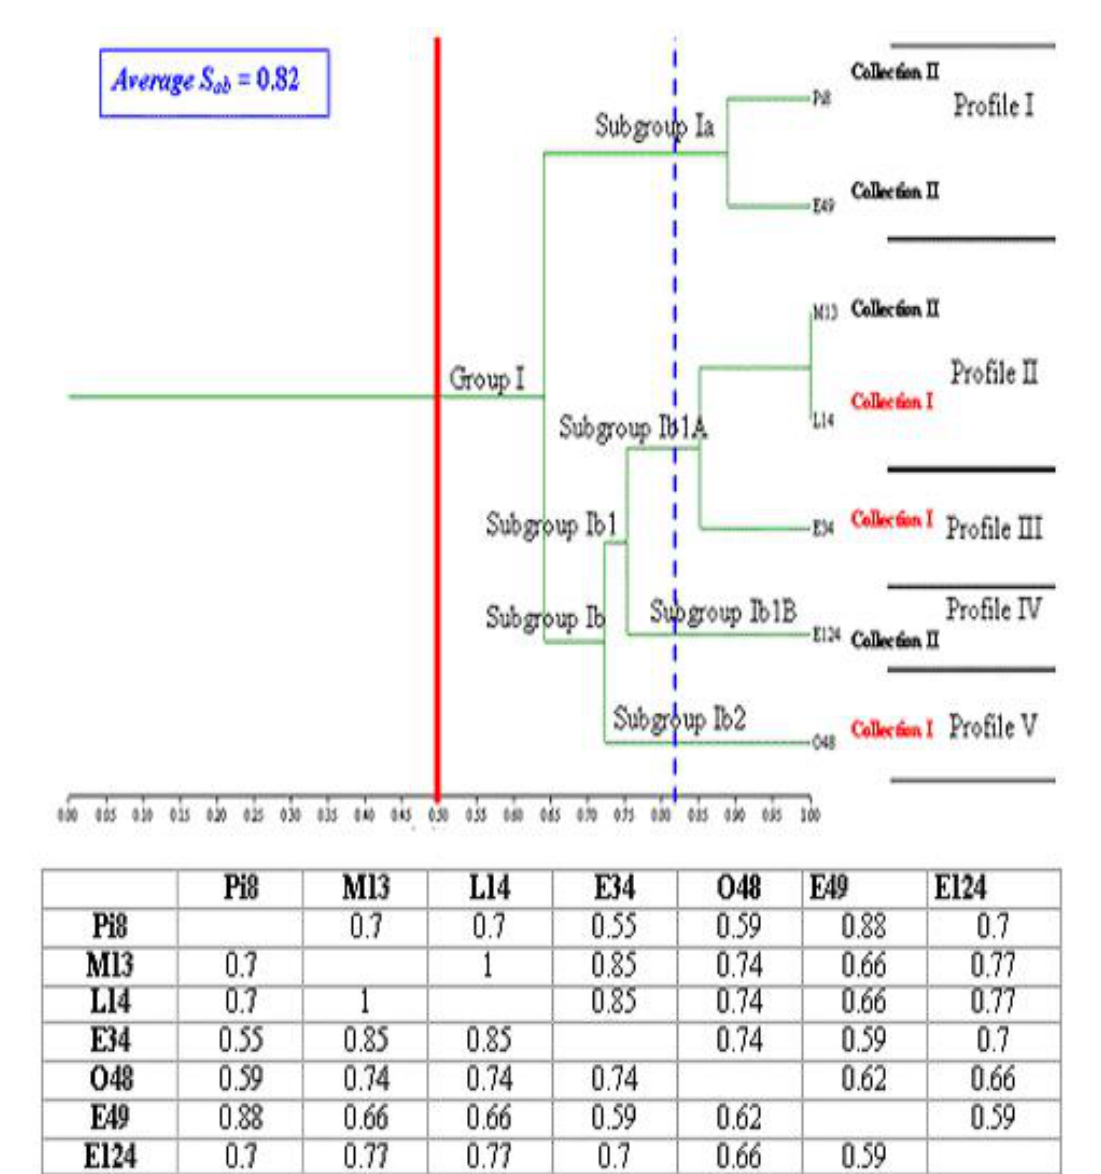
Figure 6. Dendrogram based on the S coefficients showing the genetic similarity ab developed from RAPD-PCR standards of Klebsiella pneumoniae with primer Operon 18 for simple matching coefficient. S average indicated by the hatched line. ab Pi: isolates from lavatory basin; L: isolates from gloves; O: isolates from eyeglasses; E: isolates from hand skins of surgeon-dentists; M: isolates from